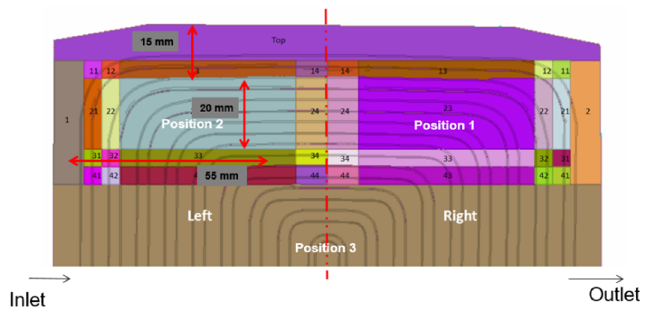
Figure 6. Heat flux sensor (HFS) positions for model development.